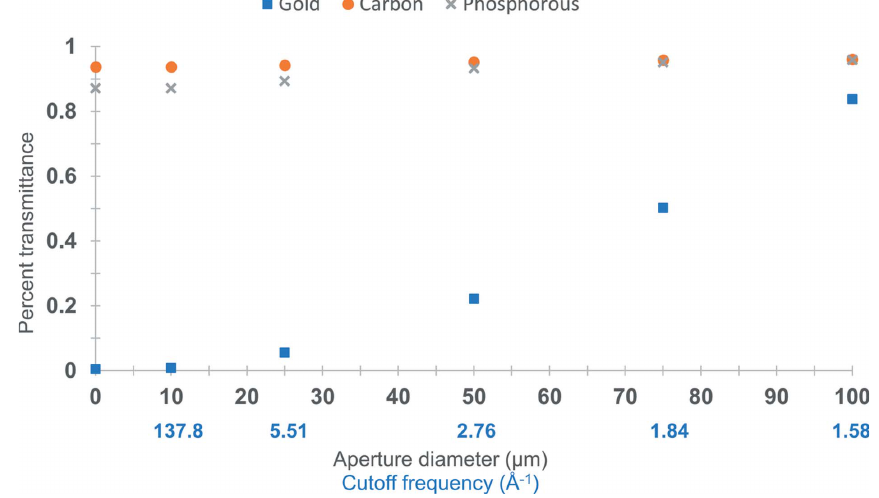
Figure 4 Scattering outside the objective lens aperture generates amplitude loss that varies based on atomic species. The smallest value calculated here (0.01 m m) is a proxy for scattered versus not scattered electrons. A simulated amorphous carbon layer (as in Fig. 1) scatters a total of (cid:4) 6.2% incident